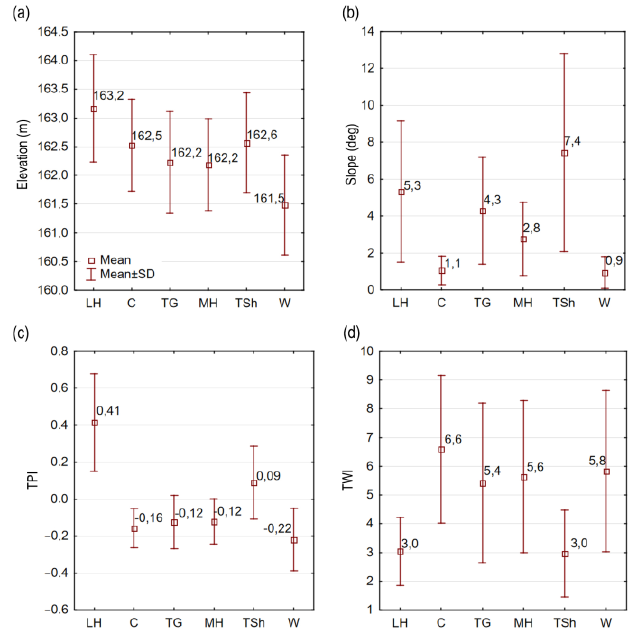
Figure 7. Means and standard deviations (SDs) of morphometric variable values for LCC over all image pixels ( a )—elevation, ( b )—slope, ( c )—topographic position index, and ( d )—topographic wetness index. Table 4. Percentage distribution of land cover classes computed by three machine-learning algo- rithms.